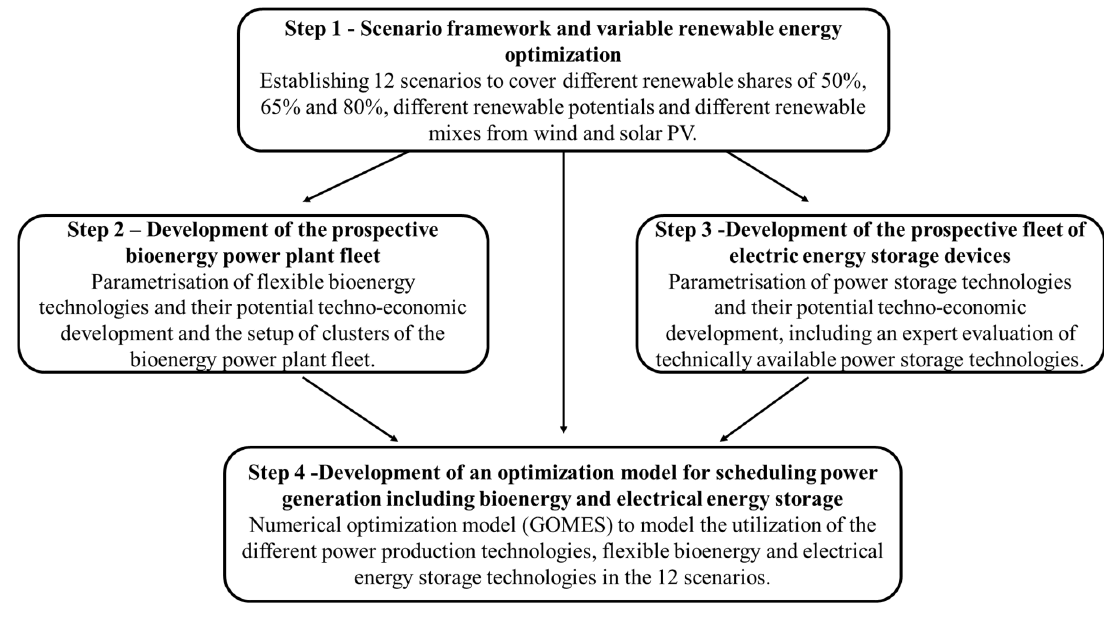
Figure 1. Methodological overview.